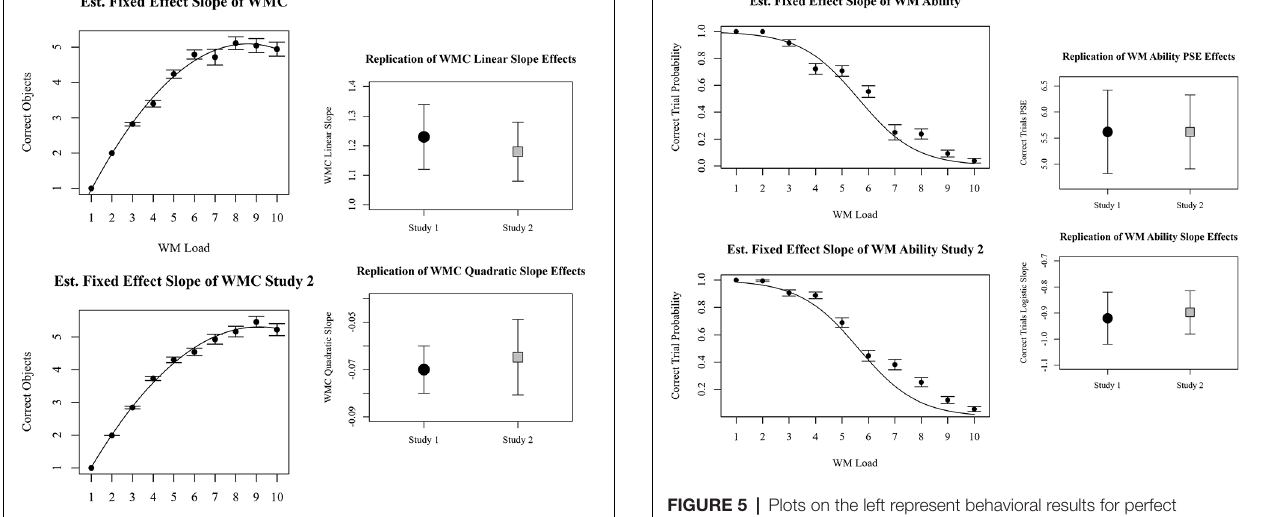
FIGURE 5 | Plots on the left represent behavioral results for perfect accuracy trials for each memory load. Results from study 1 are top left, and results from study 2 are bottom left. Beta coefficients and 95% confidence intervals of linear and quadratic slopes for correctly reported dots in study 1 and study 2 are compared on the